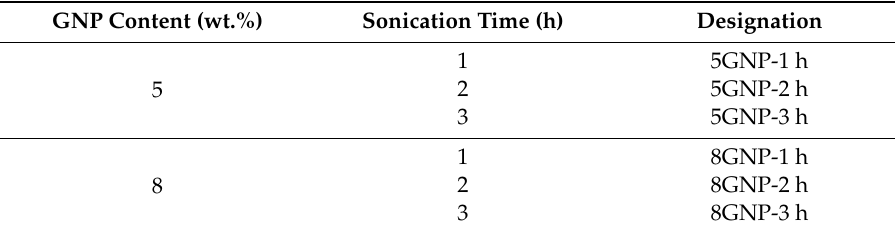
Table 1. Nomenclature used for materials manufactured and tested.